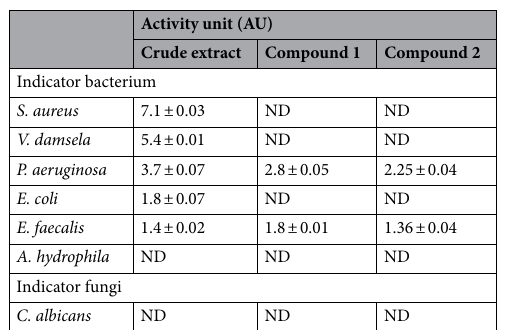
Figure 7. Histopathological analysis of liver in vivo study using laboratory animal for cytotoxicity and anticancer activity, where picture ( a ) liver of a healthy control mouse, ( b ) liver of tumor-bearing mouse treated with O. dentata extract with no abnormal changes. ( c) Ehrlich tumors of untreated mouse. ( d ) Ehrlich tumor of O. dentata treated mouse showing deeply chromatic pleomorphic nuclei with wide areas of necrosis.